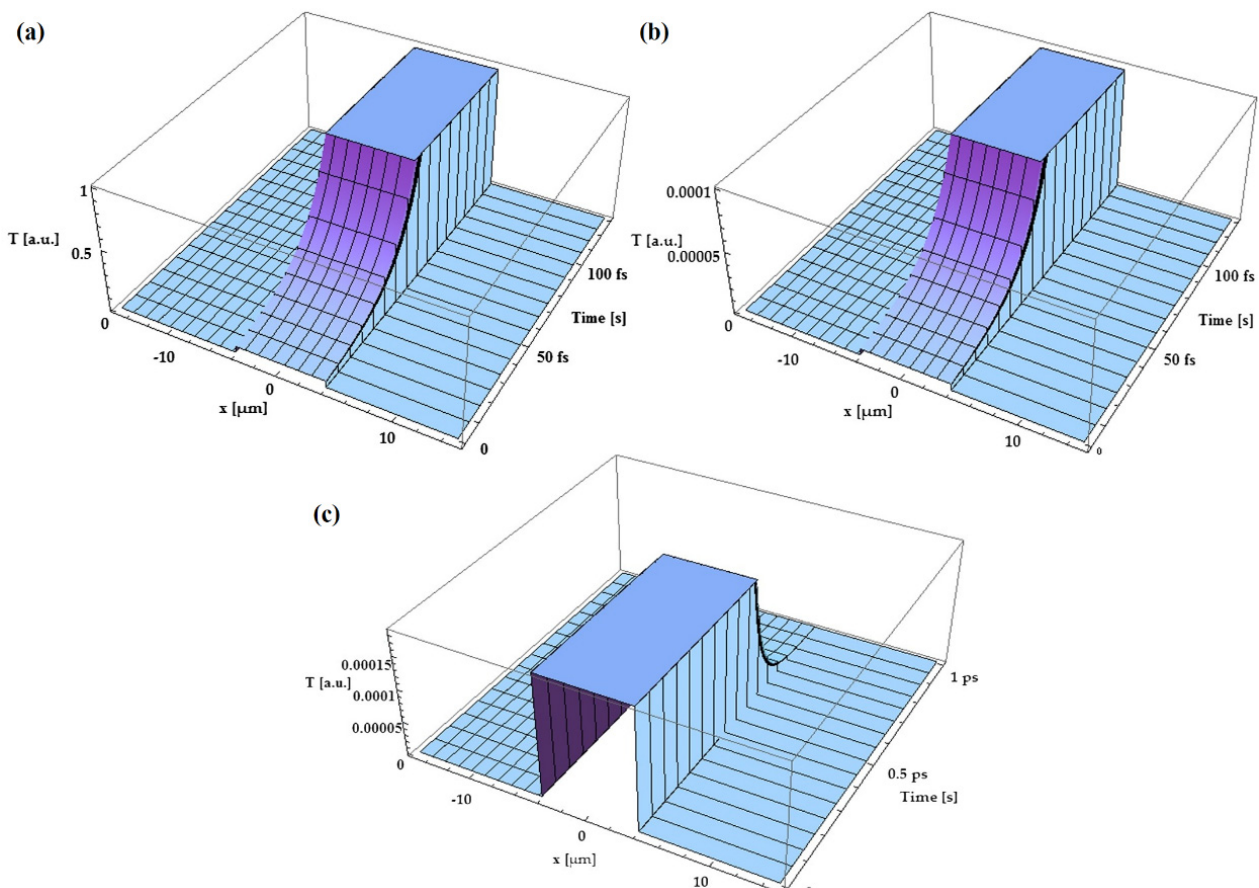
Figure 6. ( a ) Normalized electron thermal field in arbitrary units on the surface of an Au target versus time and distance. ( b ) Normalized electron thermal field in arbitrary units at distance = 4 µm, and ( c ) normalized electron thermal field in arbitrary units inside the Au target, at a depth of distance = 4 µm versus time (from 0 to 1 ps) and distance [40]; with permission from Elsevier.